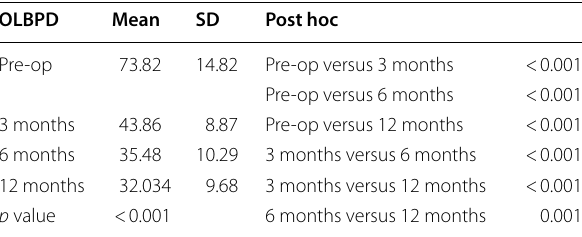
Table 3 Changes in mean OLBPD score at different time intervals OLBPD